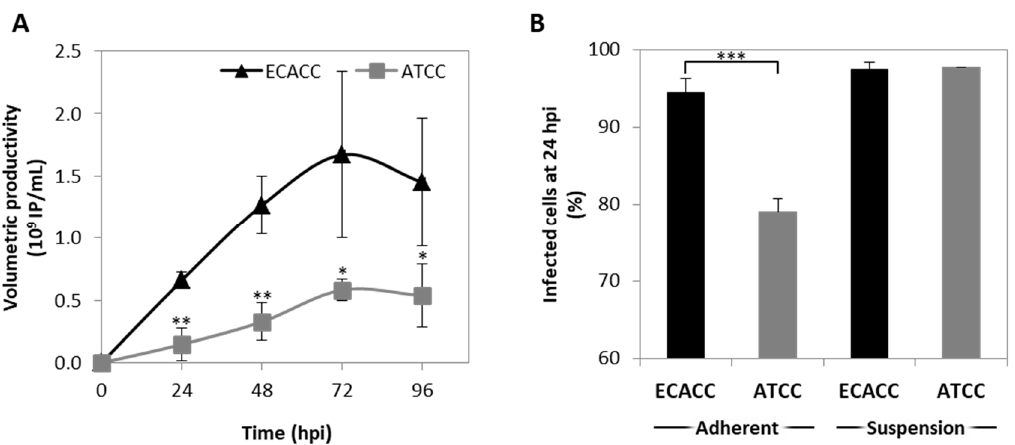
Figure 4. CAV-2 infection permissiveness in MDCK cells from ATCC or ECACC in suspension cultures in AEM medium. ( A ) Volumetric productivity of CAV-2 infectious particles (IP) is given as average ± standard deviation ( n = 3). Infection was performed with CAV-2pIX-GFP virus at MOI of 1 and infectious particles titer determined in dog kidney (DK)-E1 cells as detailed in Materials and Methods * p < 0.05, ** p < 0.01, given by a Welch’s t-test, comparing values obtained at the same time point. ( B ) Percentage of GFP + cells at 24 h post infection (hpi) upon transduction with a non-replicative E1-deleted CAV-2 at MOI of 10 for both adherent and suspension cultures to achieve synchronous infection. GFP + cells were considered infected and quantified by flow cytometry. Values are shown as average ± standard deviation ( n = 3). *** p < 0.001, given by a Welch’s t -test.